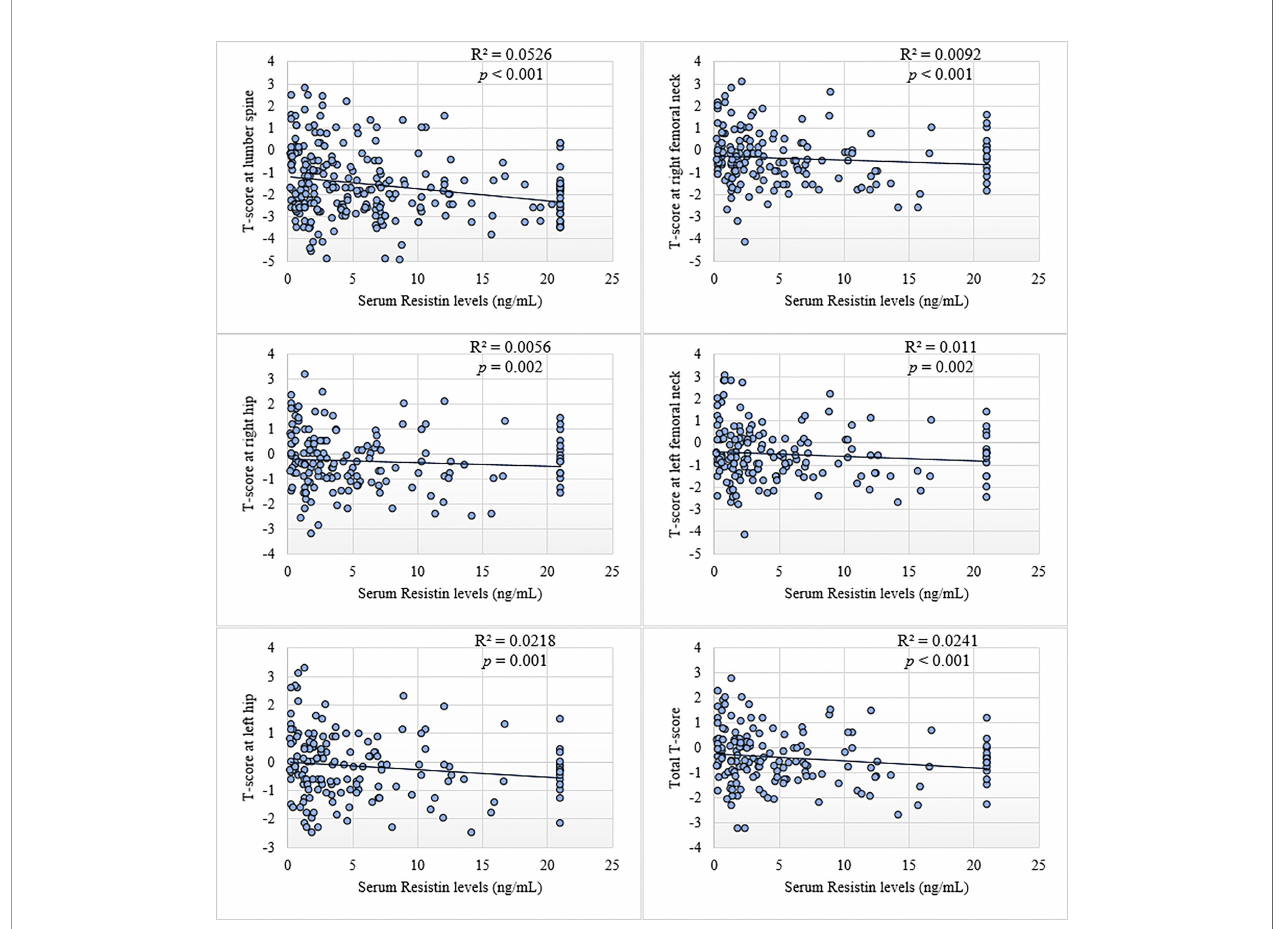
FIGURE 1 | Scatter plots showing correlation of BMD (T-scores) with serum resistin levels in postmenopausal